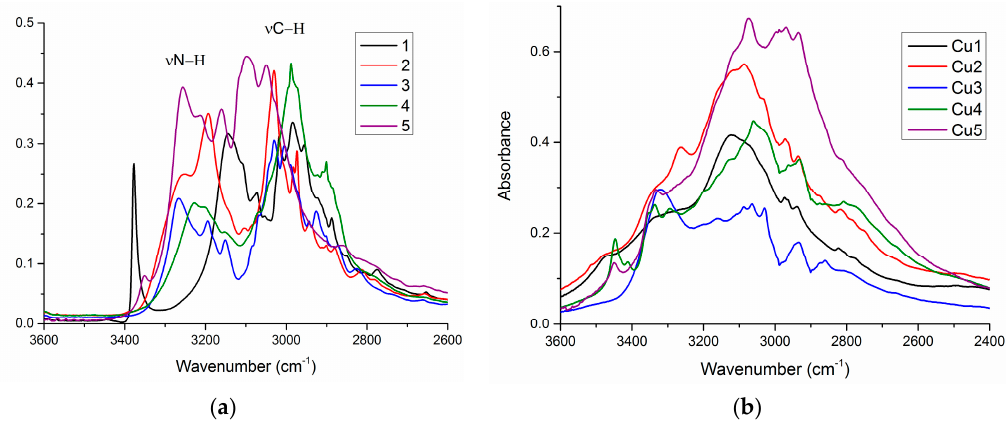
Figure 2. ATR-IR spectra of ( a ) ligands in the region 3600–2600 cm − 1 ( b ) and their Cu(II) complexes in the region 3600–2400 cm − 1 .